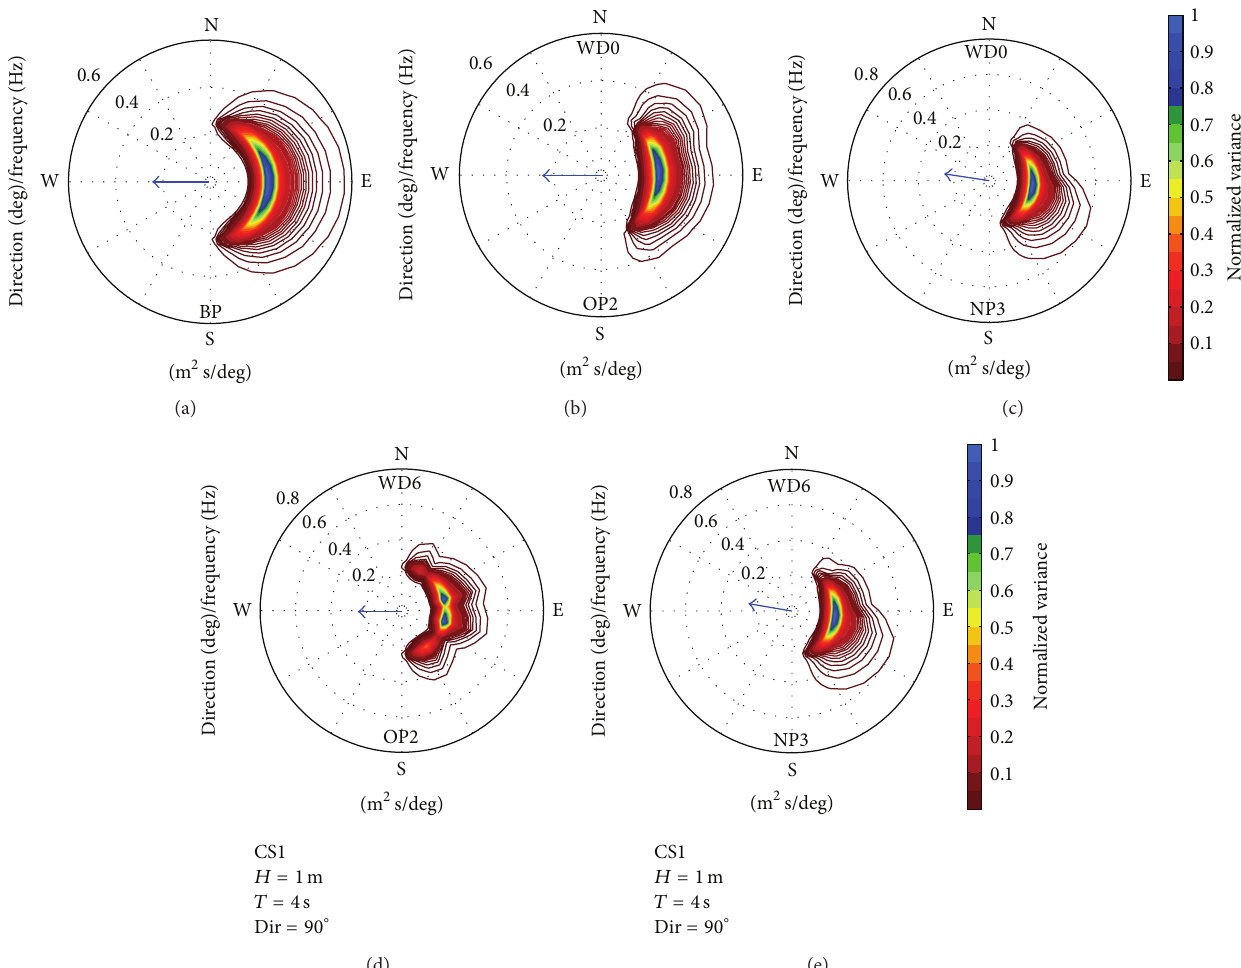
Figure 8: Evaluation in the spectral space of the impact on the wave field of a wave farm based on Wave Dragon WECs that operate in the target area for CS1. (a) BP for WD0. (b) OP2 for WD0. (c) NP3 for WD0. (d) OP2 for WD6. (e) NP3 for